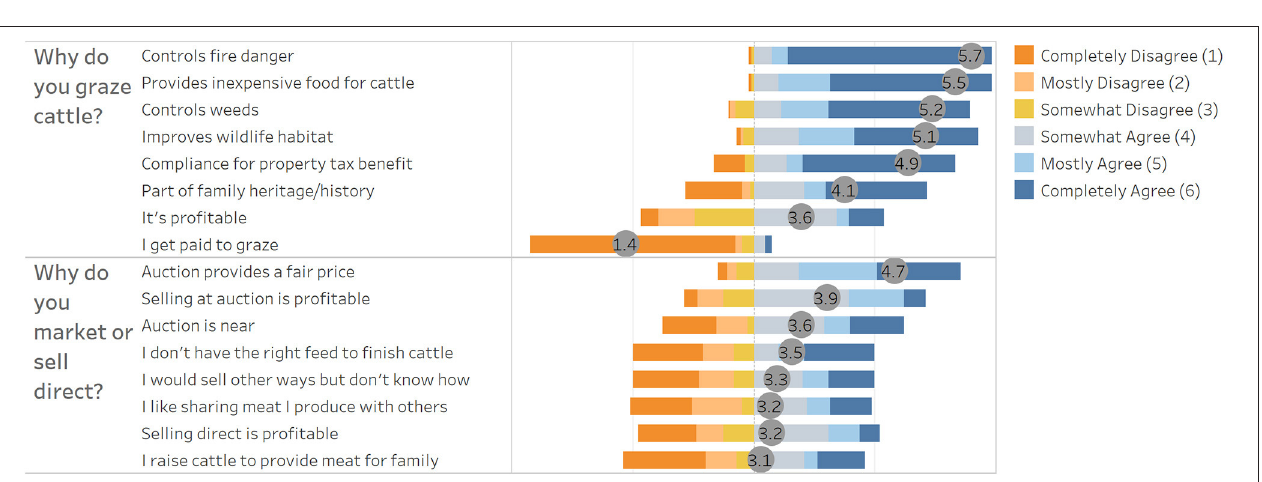
FIGURE 7 | Reasons small-scale beef producers in the San Francisco Bay Area, California graze cattle and sell at auctions or market directly, survey responses. In addition to the cows moved from grazing land to processing facilities, the cattle movement data documents transhumance, at least when it occurs across state lines. Approximately 50,000 cows, some with calves, left annual rangelands in California in the late spring for grazing lands in Oregon, where there is green summer rangeland or irrigated